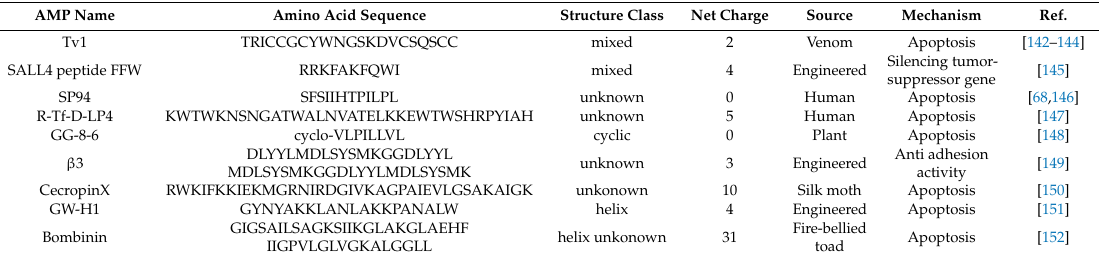
Table 3. List of the most representative antimicrobial peptides acting against